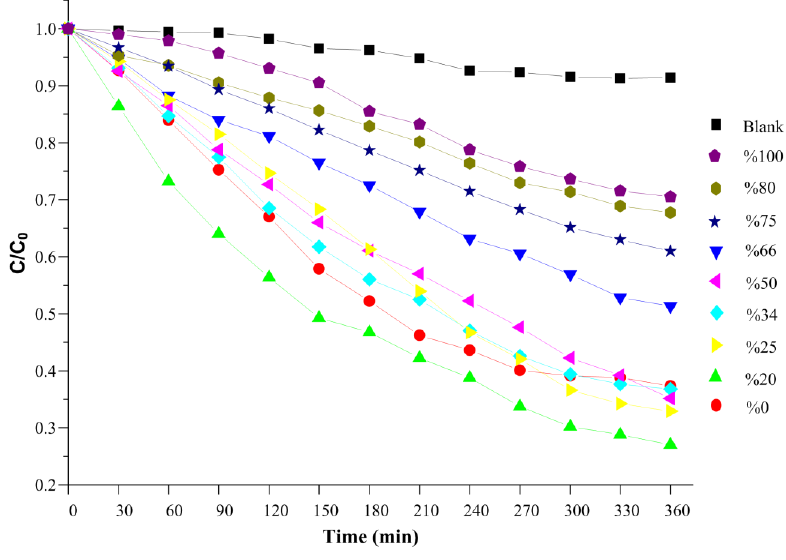
Figure 10. Photodegradation of MB in the presence of ZnS and CdS nanoparticle mixtures with different ZnS weight percentages under visible light.